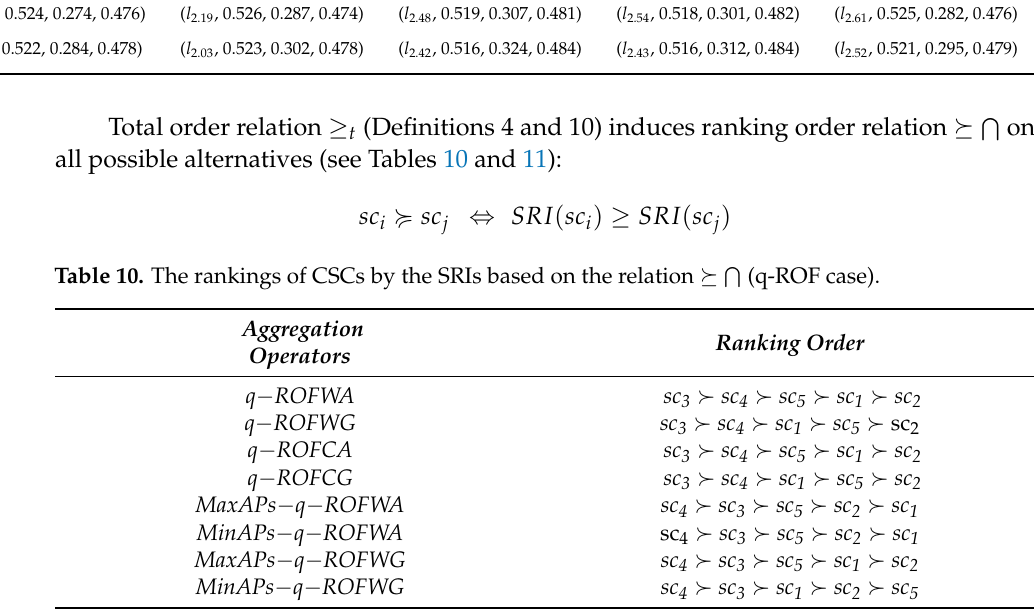
Table 11. The rankings of CSCs by the SRIs based on the relation (cid:23) (cid:84) (q-RPL case). Aggregation Operators